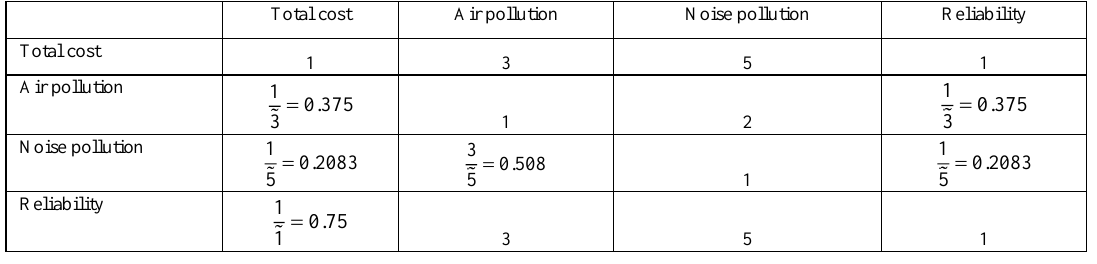
Table 7. Random index